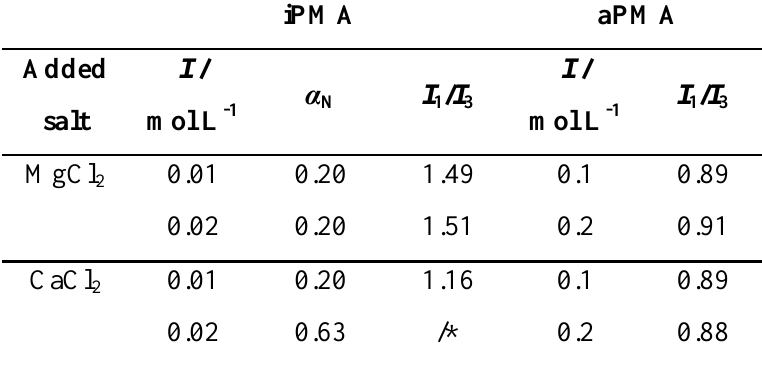
in solutions with different ionic strength I and at 2